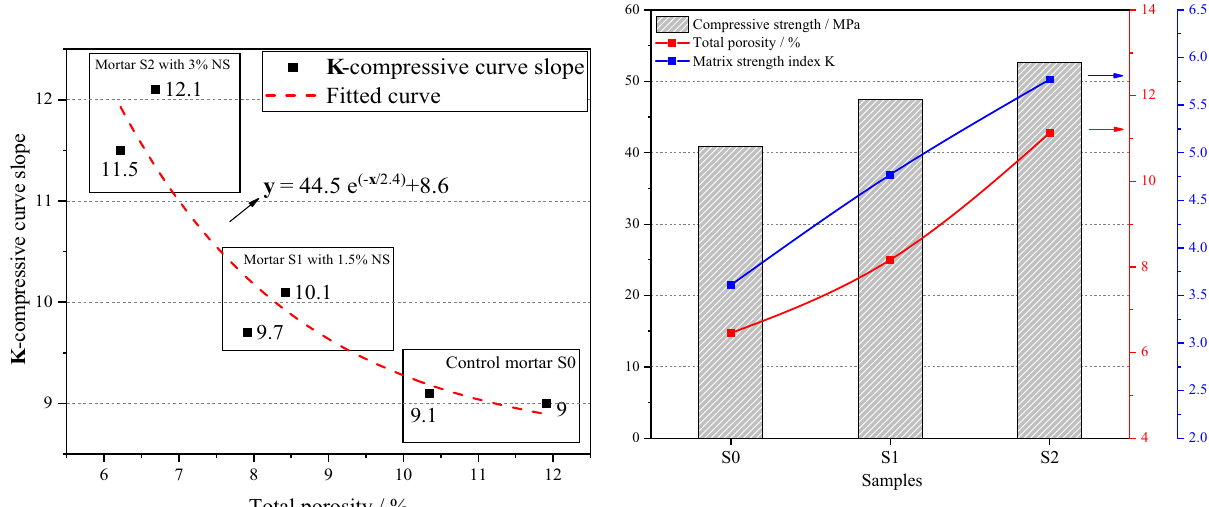
Figure 16: Trend curves of compressive strength, total porosity, and matrix strength index